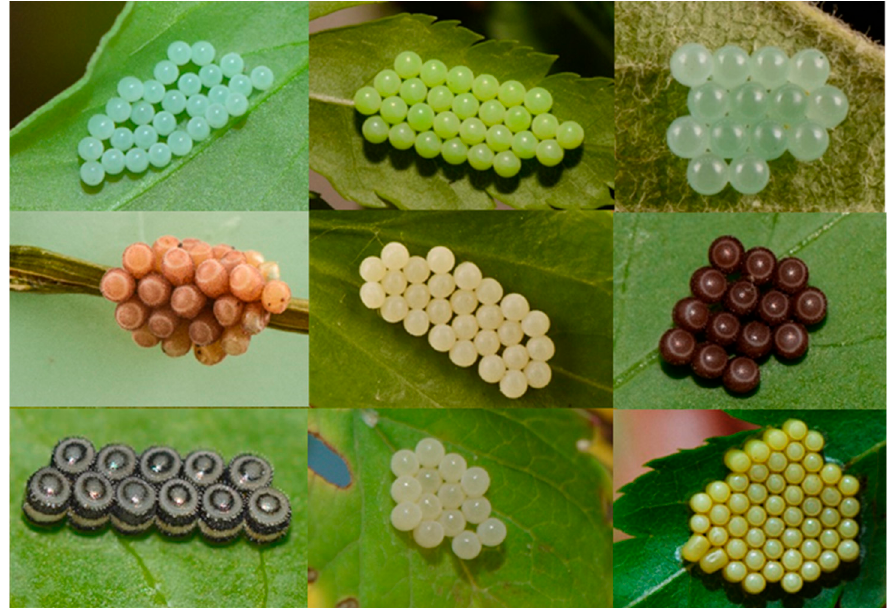
Figure 3. Egg masses of common stink bugs that are easily confused (always from left to right): top row : Halyomorpha halys , Palomena prasina , Pentatoma rufipes ; middle row : Dolycoris baccarum , Graphosoma italicum , Carpocoris fuscispinus ; bottom row : Piezodorus lituratus , Peribalus strictus, Nezara viridula .